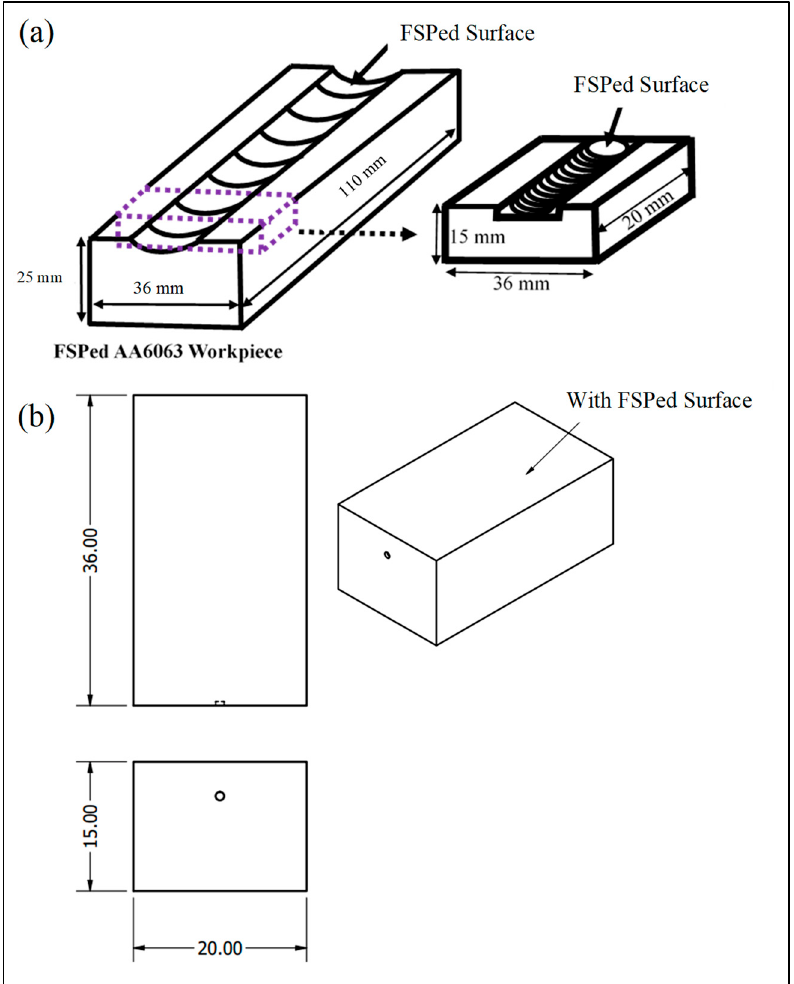
Figure 3. Microstructure and hardness test sample, ( a ) cut from FSPed workpiece, and ( b ) CAD